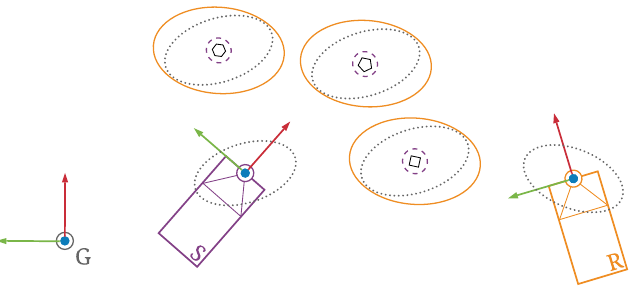
Figure 8. Coordinate transformation of perception information with uncertainty considered from the sensing ITS-S S to the receiving ITS-S R